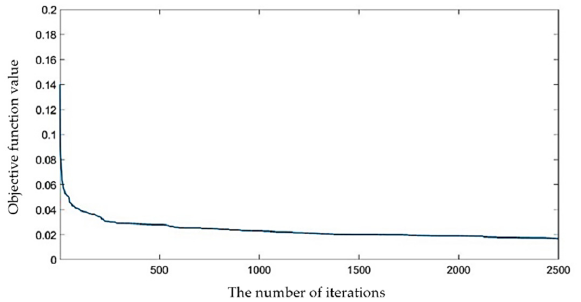
Figure 5. The value of the objective function changes with the number of iterations.